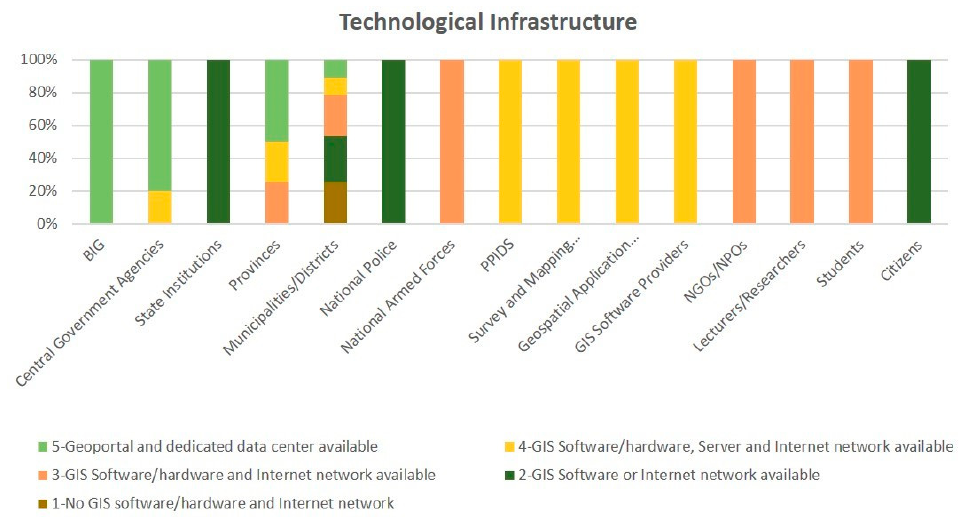
Figure 5. Questionnaire results on technological infrastructure.